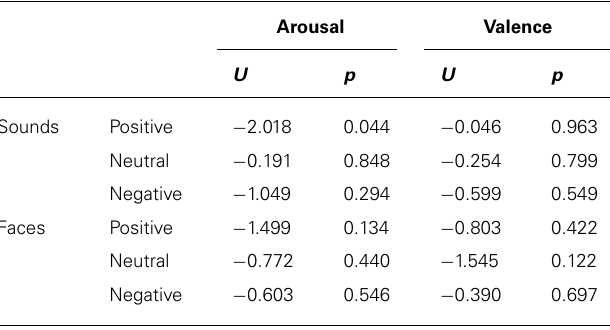
Table 3 | Group comparisons of unimodal valence and arousal ratings of sounds and faces – findings of Mann–Whitney- U tests. Arousal Valence